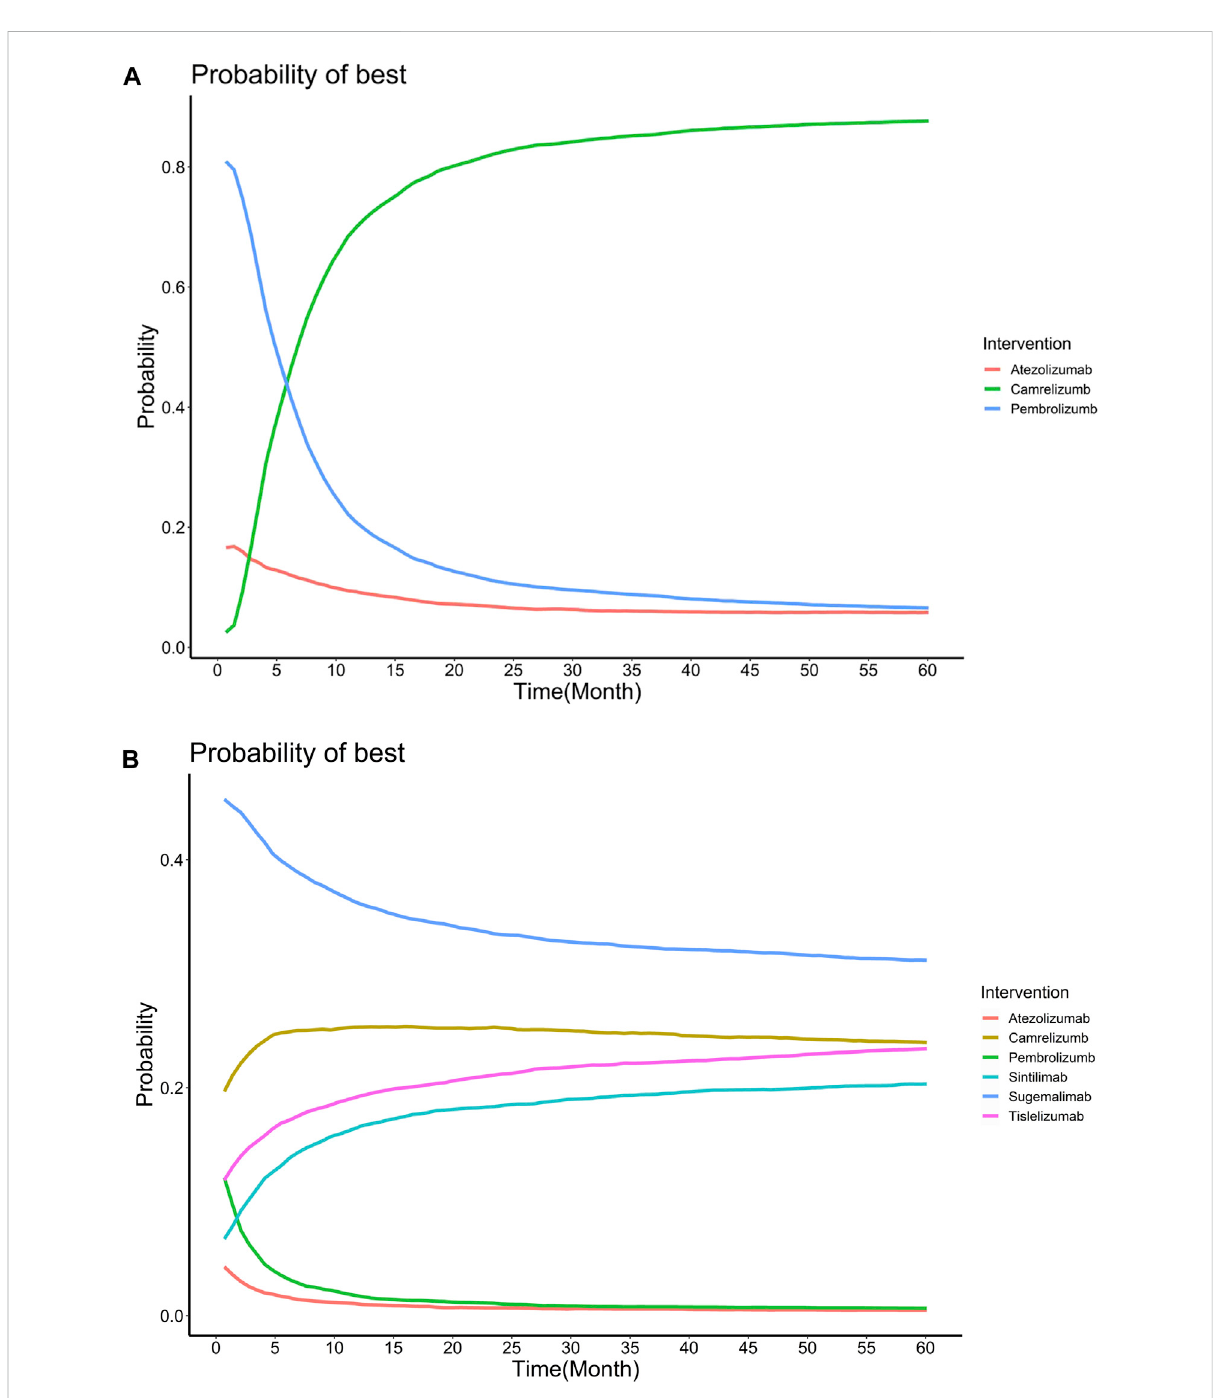
FIGURE 3 Treatment probabilities of optimal effectiveness over time for overall survival (A) and progression-free survival (B) for different regimens added to chemotherapy.